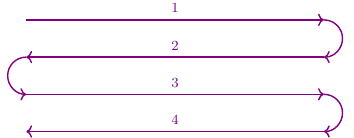
Figure 1 . A contour with 2